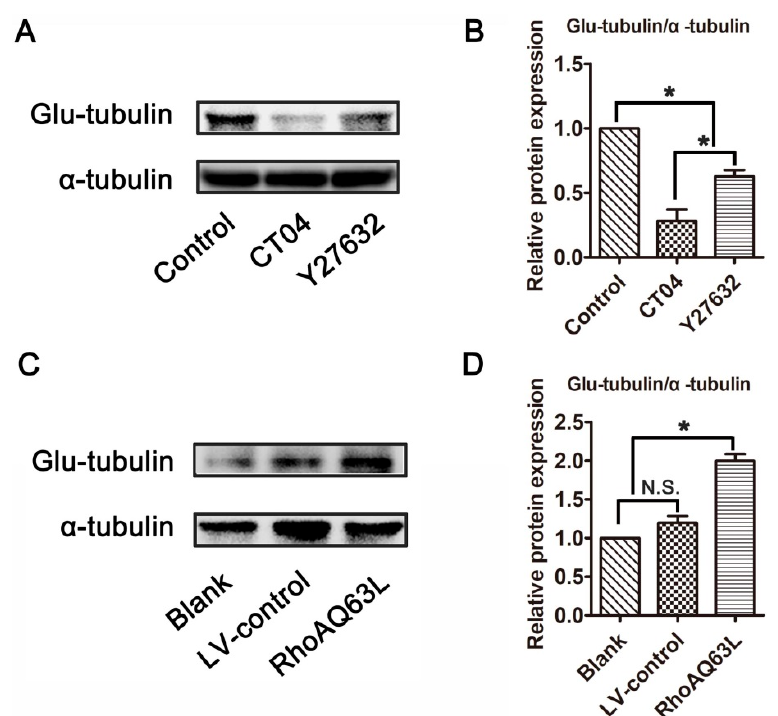
Figure 3. The RhoA signaling pathway elevates the expression of Glu-tubulin in neuronally differentiated PC12 cells. Western blots showed that the level of Glu-tubulin was remarkably downregulated in CT04- or Y27632-treated cells ( A , B ). Conversely, the overexpression of constitutively activated RhoA resulted in the upregulation of Glu-tubulin ( C , D ). The ratio of Glu-tubulin/total tubulin ( α -tubulin) in the control group was normalized to 1. The data are shown as the mean ± SEM values (*indicates p < 0.05, meaning a statistically significant difference, while N.S. indicates non-significance).